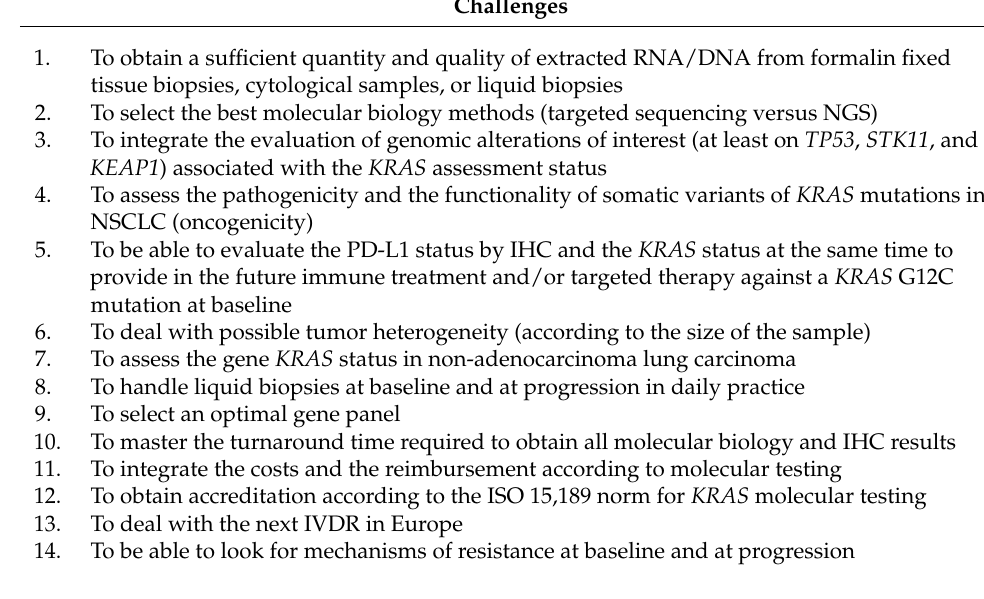
Table 2. Challenges associated with routine clinical testing of KRAS mutations in NSCLC for a pathology laboratory. NGS, next generation sequencing; IHC, immunohistochemistry; IVDR, in vitro drug